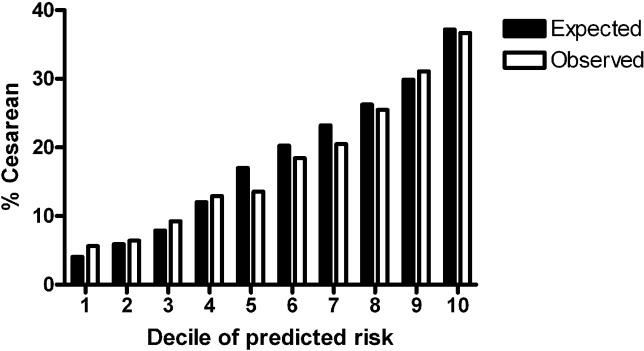
Use of ALLRs to Predict Probability of Cesarean Section among Women Delivered 37 to 39 wk with a Documented Duration of Labor of Greater than or Equal to 4 hProbability estimated using likelihood ratios in Table 4 (excluding gestational age) and the prior odds of 0.22 (equivalent to background risk of cesarean section in this group).